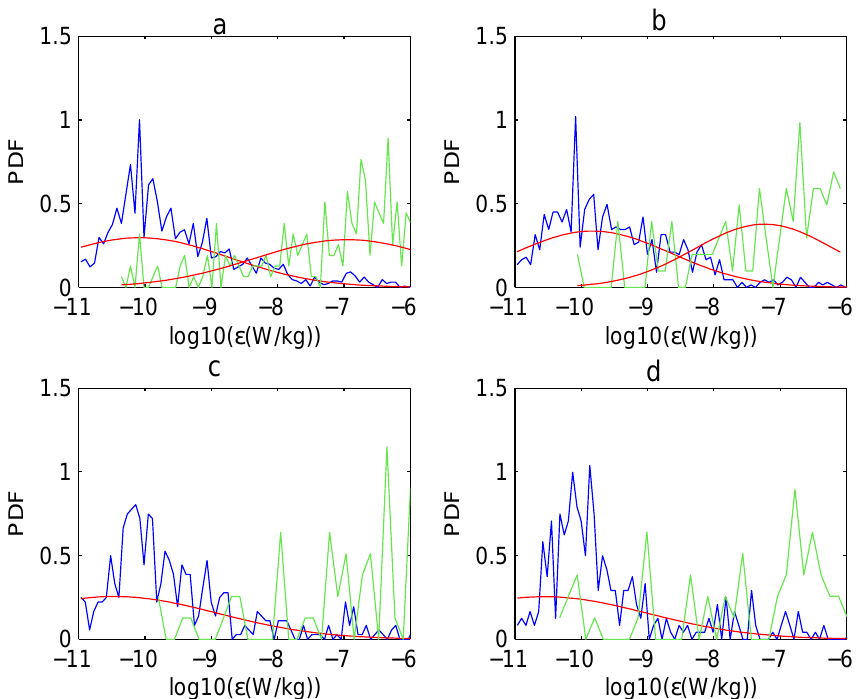
Fig. 6. Experimental PDF of the dissipation rate Log 10 ((cid:15)( Wkg − 1 )) in green for 10m < z < 20m in blue for 20m < z < 100m, in red MLE Figure 6: Experimental PDF of the dissipation rate Log 10 ( ϵ ( W.kg . − 1 )) in green for 10m<z<20m fit of a log-normal PDF: (a) for the complete LD station data set (stations A, B, C), (b) for station C, (c) for station B and (d) for station A. in blue for 20m<z<100m, in red MLE (cid:28)t of a log-normal PDF, (a) for the complete LD station data set (stations A,B,C), (b) for station C, (c) for station B and (d) for station A. Table 1. Mean SCAMP (cid:15) estimations (Wkg − 1 ) from various methods: arithmetic mean, MLE of the log-normal distribution mean, geometric